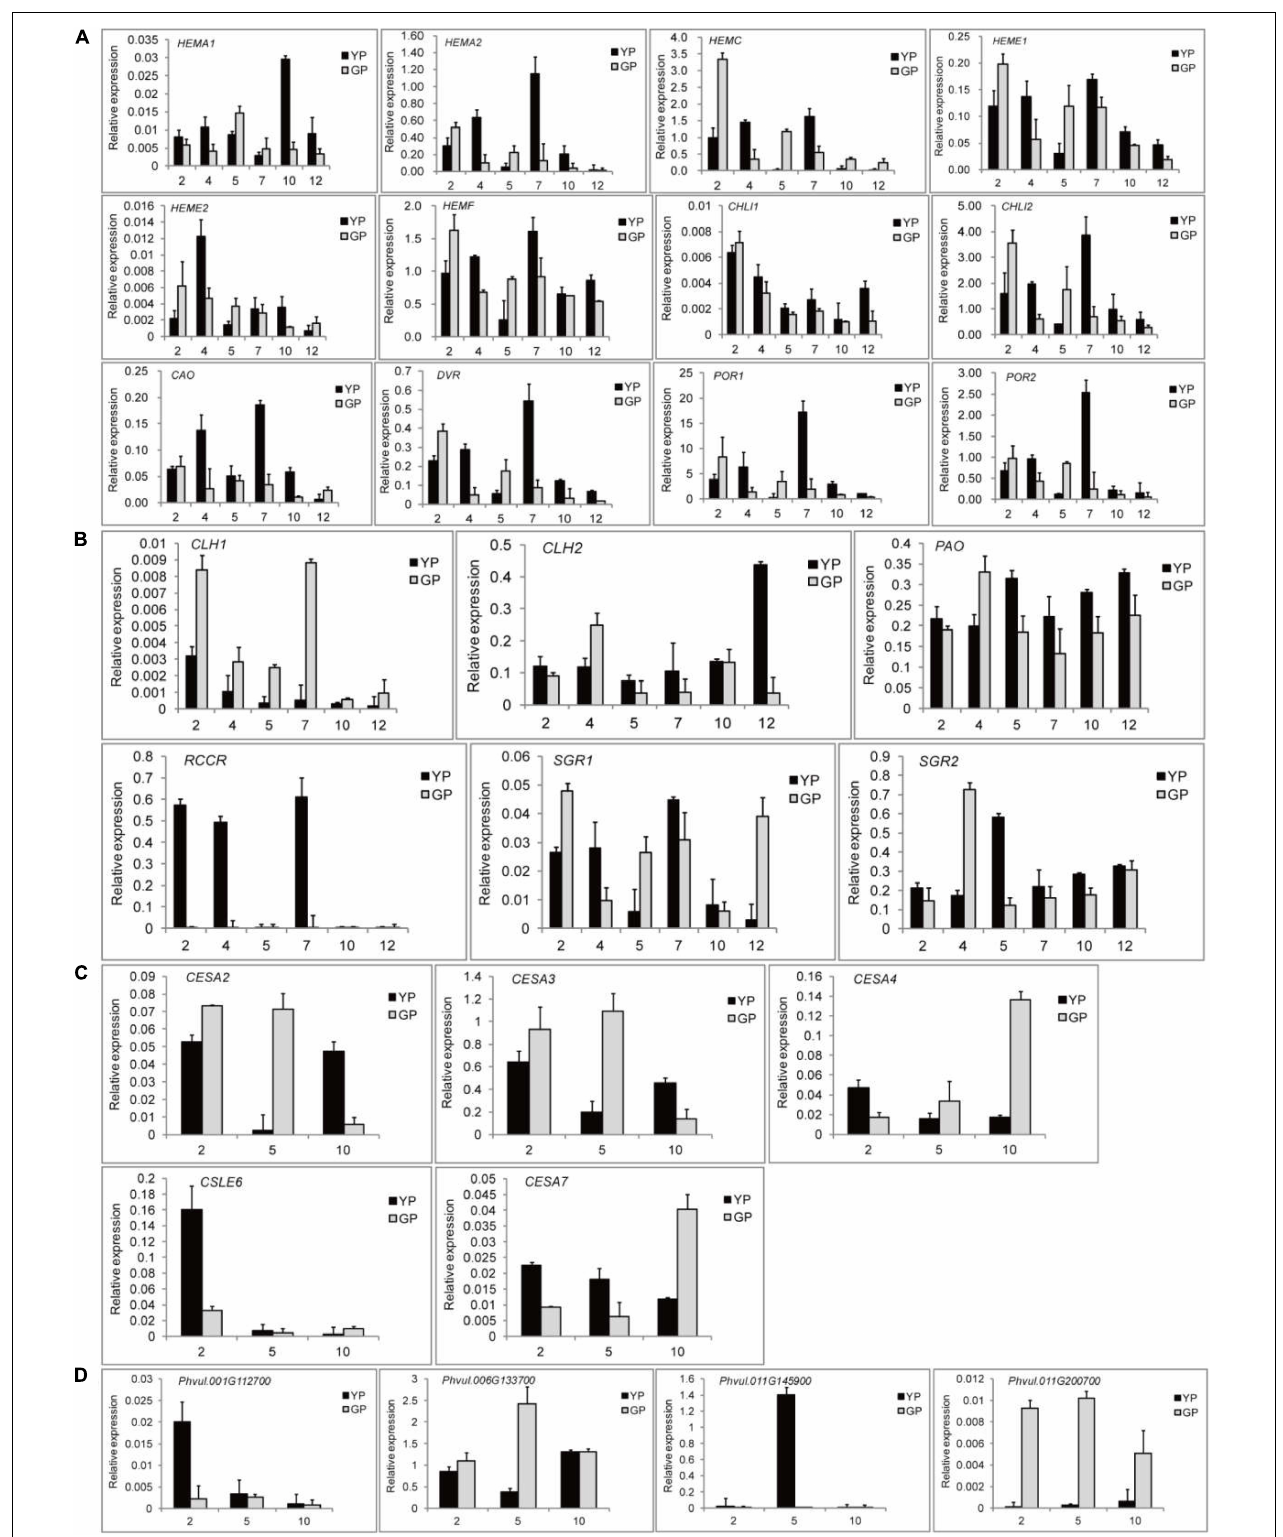
FIGURE 5 | Quantitative real-time PCR (RT-qPCR) validation of DEGs found throughout transcriptome between the wild type and mutant. (A) DEGs involved in chlorophyll synthesis. (B) DEGs involved in chlorophyll degradation. (C) DEGs involved in cellulose synthesis. (D) DEGs involved in cellulose degradation.